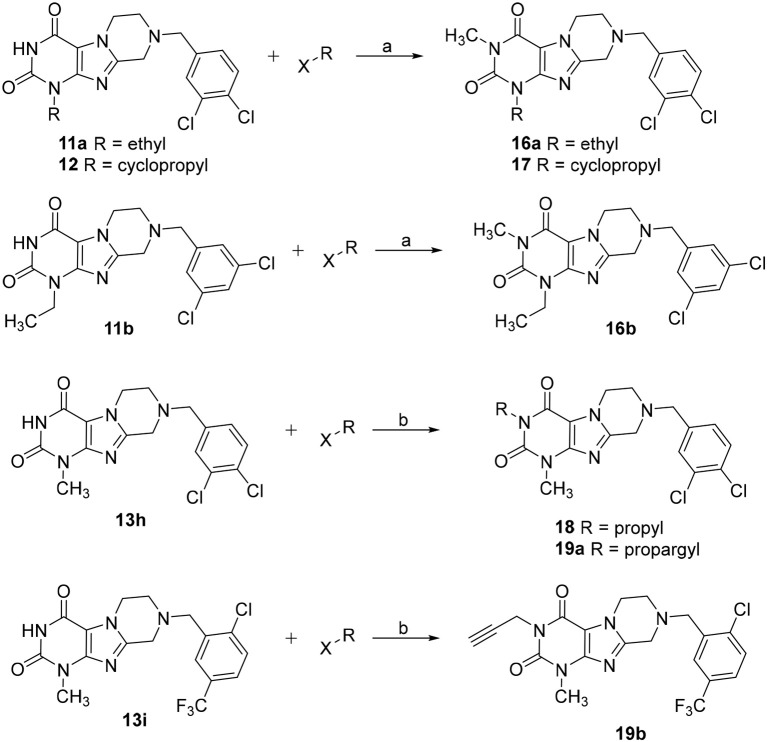
Synthesis of 3-substituted 8-(dichlorobenzyl)-6,7,8,9-tetrahydropyrazino[2,1-f ]purine-2,4(1H,3H)-diones 16–18, 19a and 8-(2-chloro-5-(trifluoromethyl)benzyl)-1-methyl-3-propargyl-6,7,8,9-tetrahydropyrazino[2,1-f ]purine-2,4(1H,3H)-dione 19b. Reagents and conditions: (a) MeI (6 eq.), KOtBu (2 eq.), THF, rt, 4 h; (b) alkyl halide (1.1 eq.), NaH (60% in mineral oil) (1.5 eq.), DMF, 8 h, 60°C.